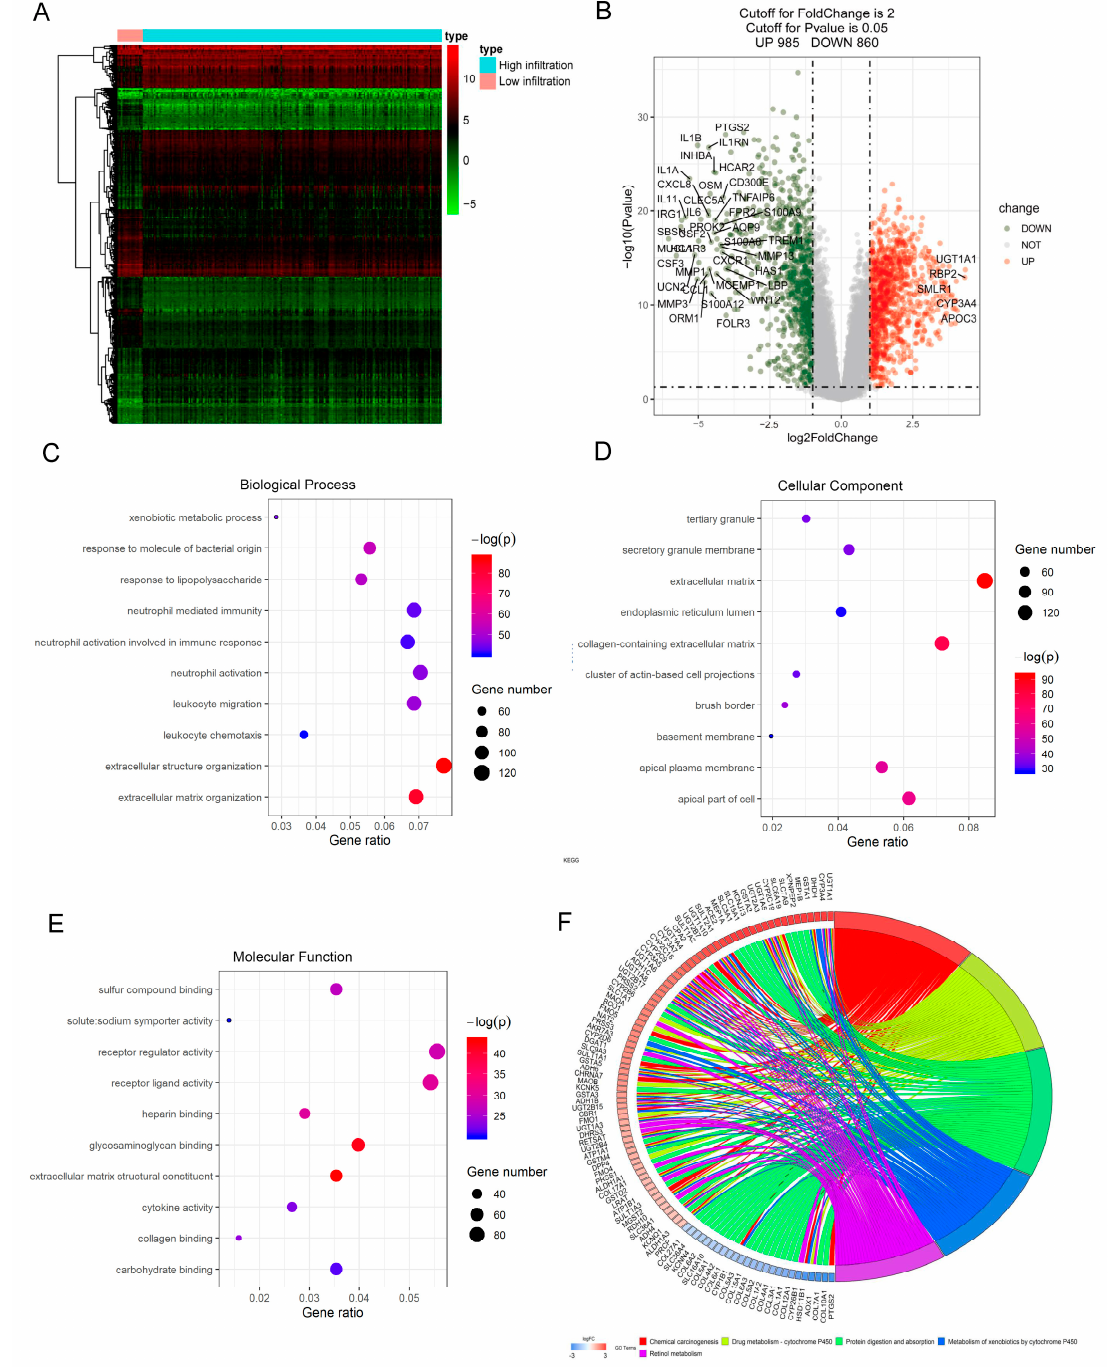
Figure 3. DEGs identified from high immune cell infiltration vs. low immune cell infiltration and their functional prediction . ( A ). Heatmap of DEGs. ( B ). Volcano plot of DEGs. Green plots represent downregulated genes, while red plots represent upregulated genes. A gene name is given when the |log 2 FC (fold change)| > 4 and p < 0.01. ( C – E ) Enrichment of DEGs using GO analysis is visualized regarding Biological Process, Cellular Component, and Molecular Function, respectively. The larger the circle in the panel, the more genes it contains; lower p values are indicated with red color. ( F ). Circle plot of first five enrichment pathways for DEGs using KEGG analysis. DEGs, differentially expressed genes; GO, Gene Ontology; KEGG, Kyoto Encyclopedia of Genes and Genomes.